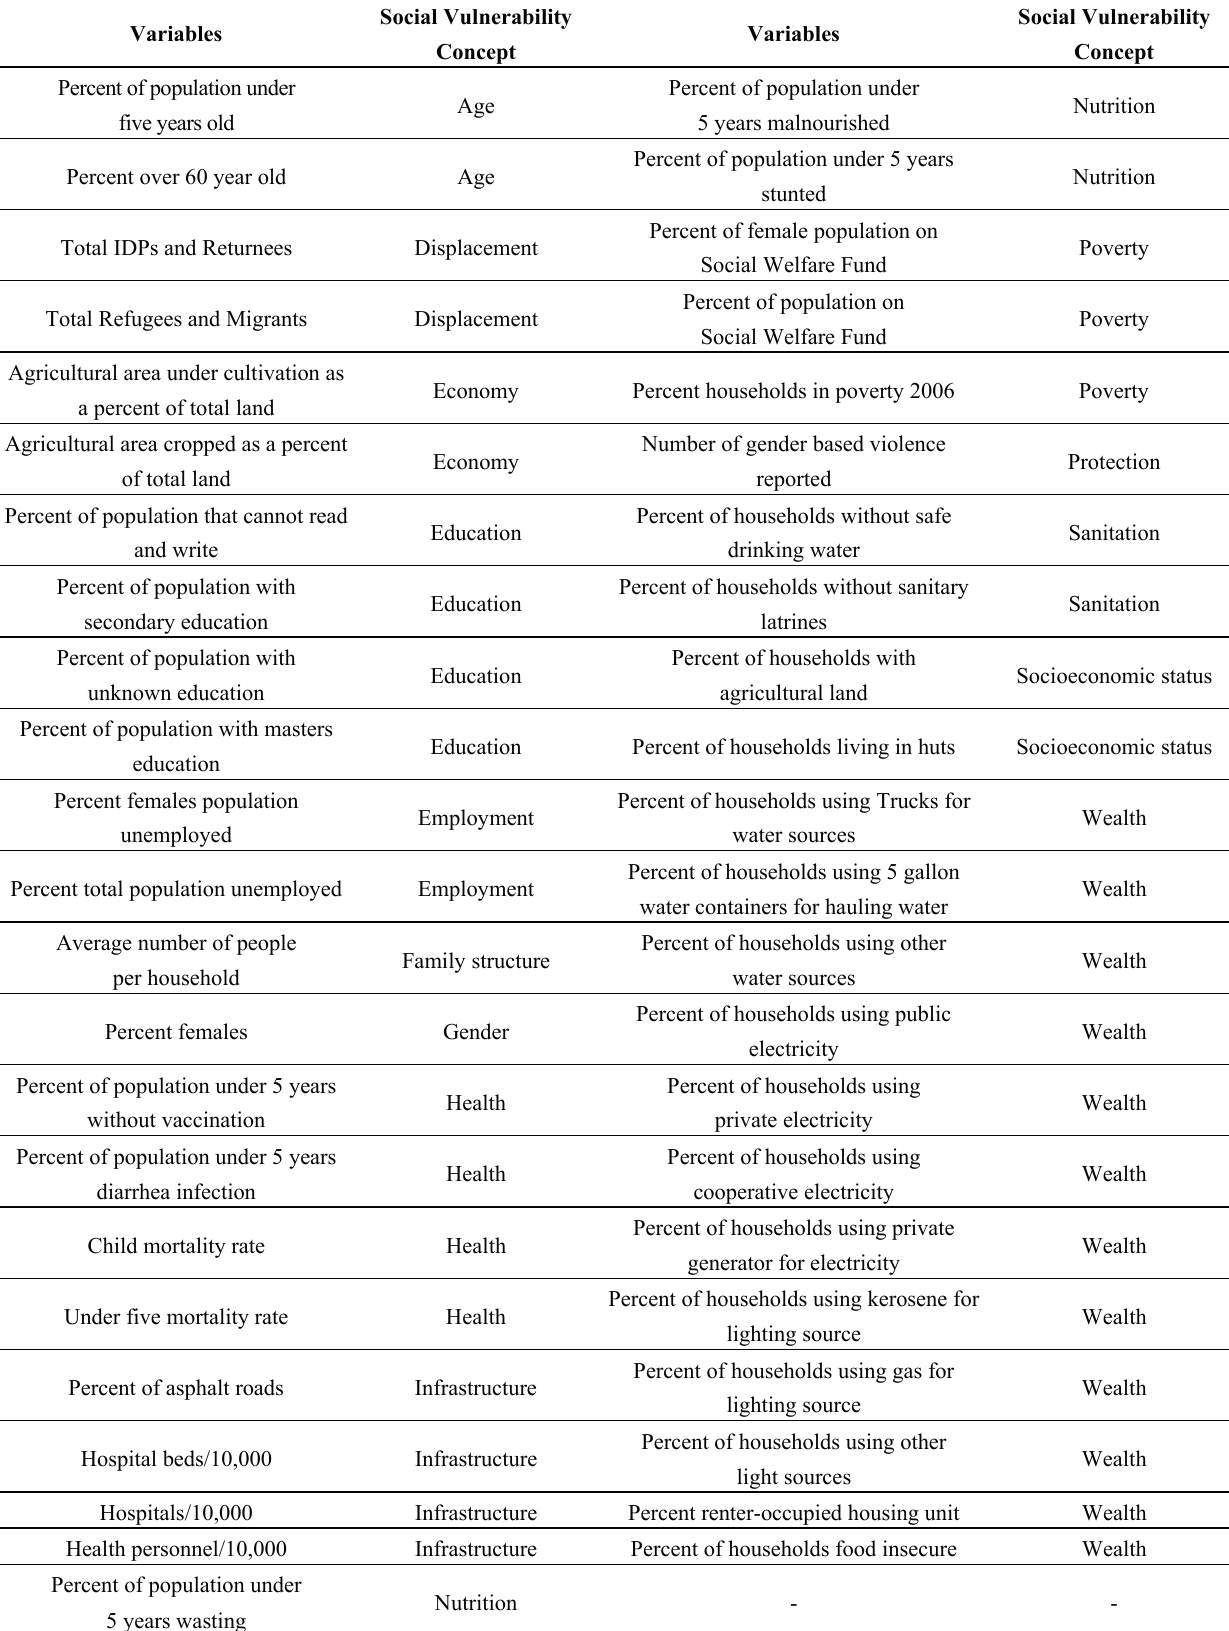
Table 1. Social variables and the concept of social vulnerability each variable